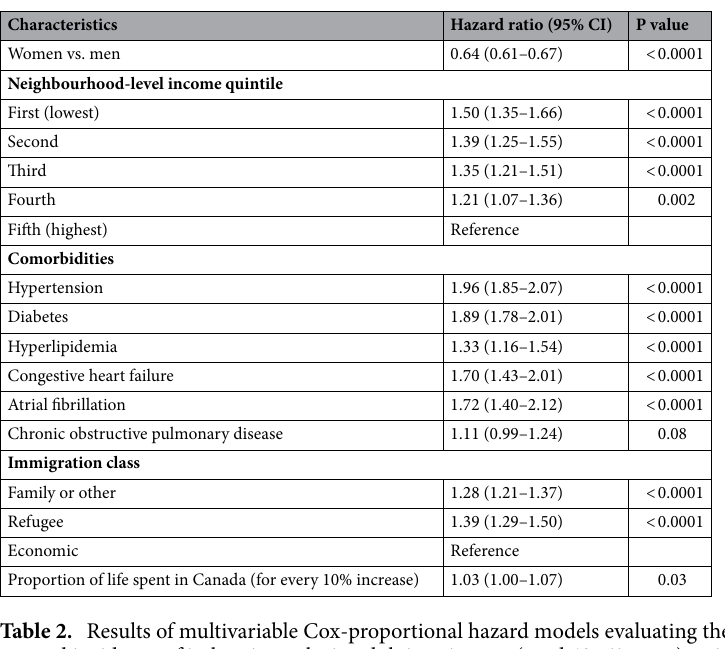
Table 2. Results of multivariable Cox-proportional hazard models evaluating the association between sex and incidence of ischemic stroke in adult immigrants (aged 40–69 years) residing in Ontario, Canada (N = 452,089). CI confidence interval.